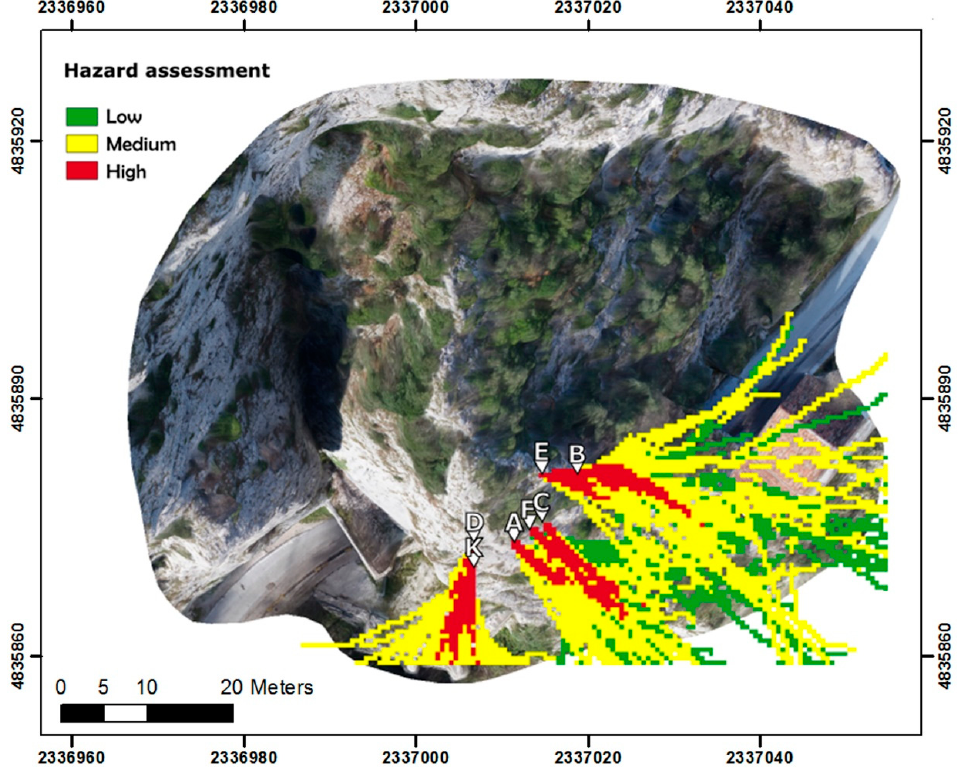
Figure 10. Rockfall hazard map.